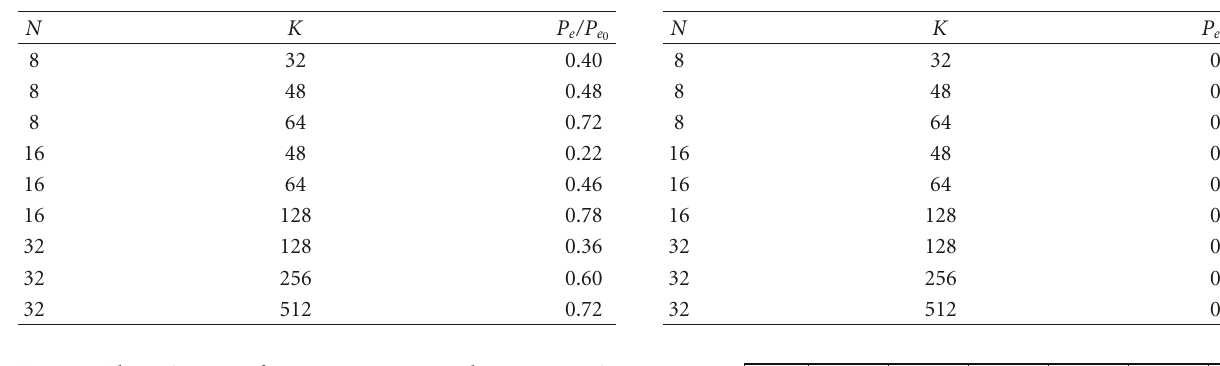
Table 2: The ratio P e /P e homogeneous clutter.